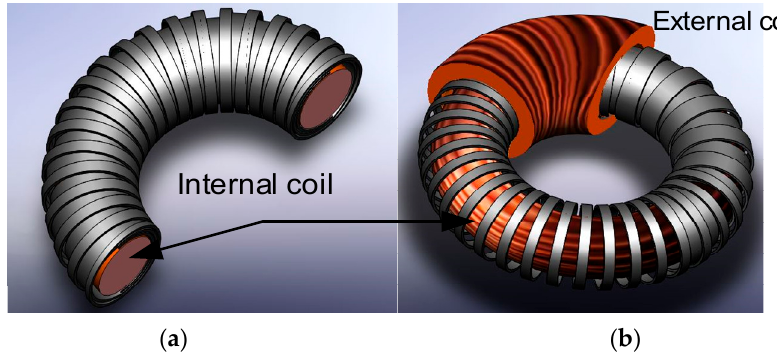
Figure 2. Schematic representation of principle to create two perpendicular coils ( a ) internal winding covered with ferromagnetic ribbon, ( b ) external coil on the ferromagnetic core.